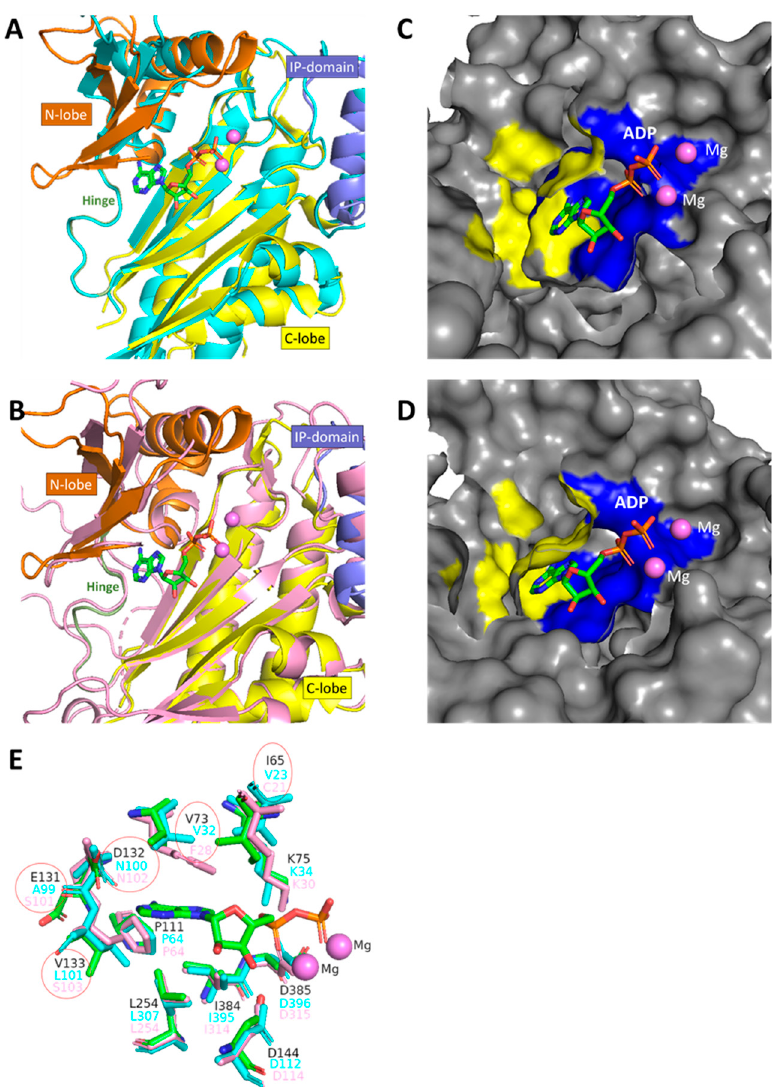
Figure 5. Overlay of the ATP binding site of Hs IPMK and the fungal IP 3-4 Ks to determine con- servation of active site residues . ADP-bound Hs IPMK structure (PDB:5W2H) showing the N-lobe in orange, C-lobe in yellow, hinge region in green and inositol binding domain (IP-domain) in blue is superimposed with the AlphaFold models of Cn Arg1 (cyan) ( A ) and Ca Ipk2 (pink) ( B ). Surface representation (in grey) of the ATP-binding pocket of Cn Arg1 ( C ) and Ca Ipk2 ( D ), with residues identical to those of Hs IPMK in blue and residues non-identical to those of Hs IPMK in yellow. Stick models depicting all residues involved in ATP binding ( E ) are depicted with Cn Arg1 in cyan, Ca Ipk2 in pink and Hs IPMK coloured green for carbon, blue for nitrogen and red for oxygen. Residues that differ among the three IP 3-4 K proteins being circled. For all panels, ADP is shown as stick representation with green for carbon, blue for nitrogen, red for oxygen and orange for phosphorus, and magnesium ions are depicted as violet